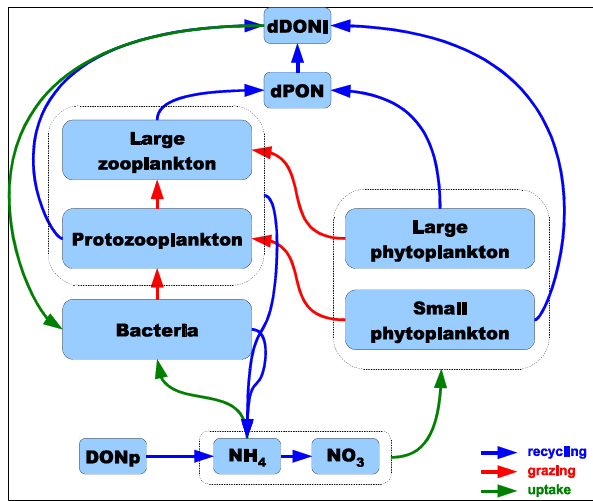
Fig. 3. Conceptual diagram of the plankton ecosystem model. The 10 state variables are nitrate (NO 3 ) , ammonium (NH 4 ) , large ( > 5µm) and small ( < 5µm) phytoplankton, copepods, protozoo- plankton, bacteria, detrital particulate and dissolved organic nitro- gen (dPON and dDONl, respectively), and photosensitive dissolved organic nitrogen (DONp). Green, red and blue arrows represent nu- trient uptake, grazing and nitrogen recycling,